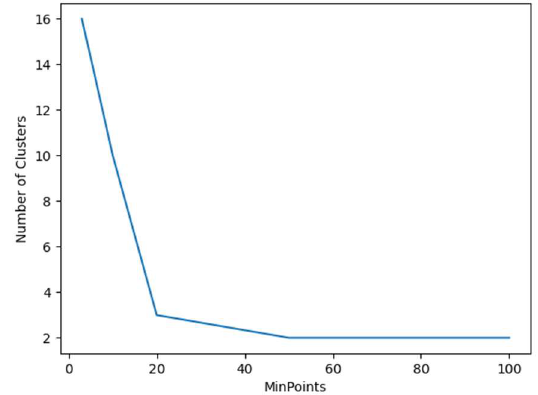
Figure 4. The output results of the number of DBSCAN algorithm clusters correspond to different input MinPts values.